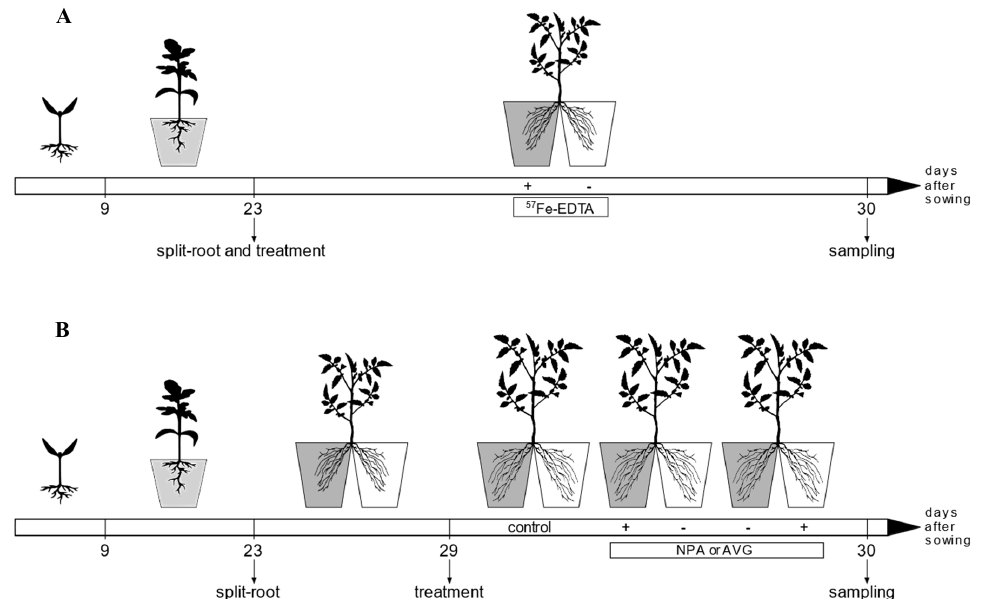
Figure 1. Schematic drawing of the experimental set up indicating: ( A ) the 57 Fe-EDTA treatment; ( B ) the supply of auxin and ethylene inhibitors.